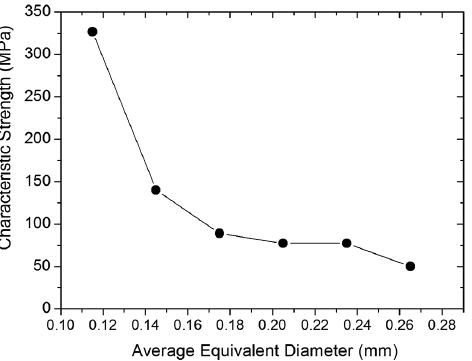
Figure 7. Variation of the PALF Weibull characteristic strength with the corresponding fiber equivalent diameter for each interval in Figure